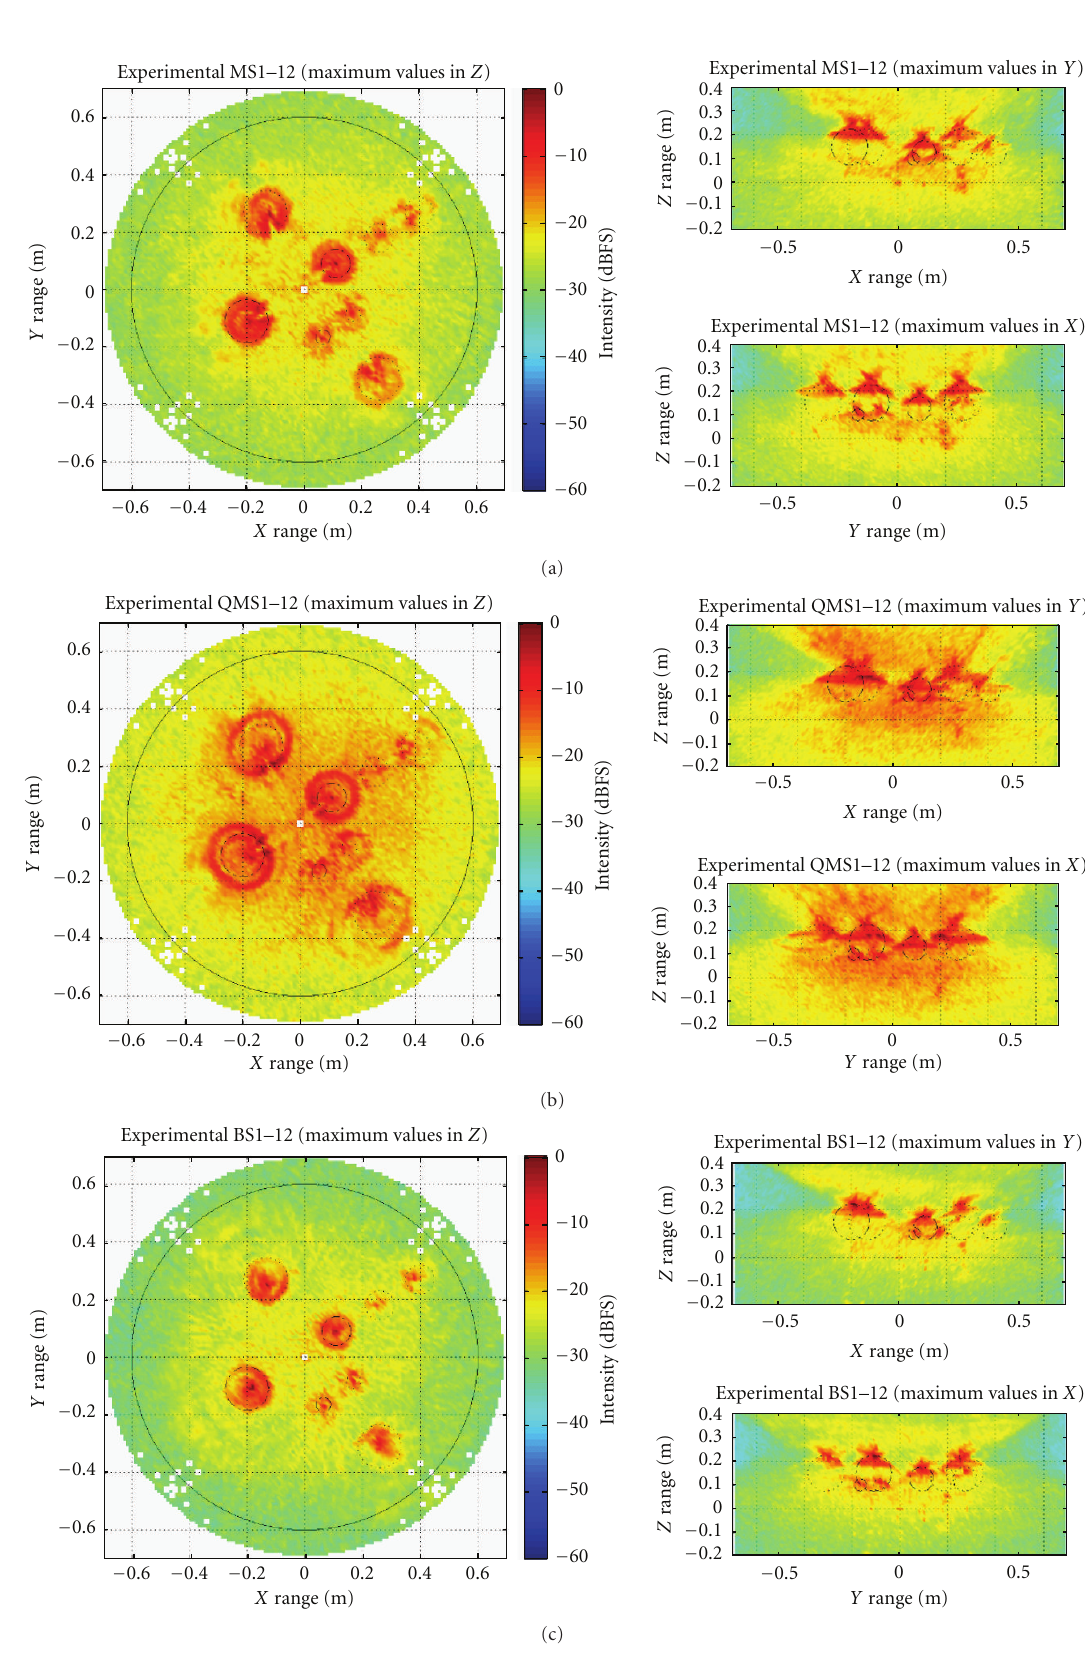
Figure 19: Experimental tomographic reconstruction of the targets seen in Figure 16. (a) (Q)MS antennas, (Q)MS algorithm. (b) BS antennas, (Q)MS algorithm. (c): BS antennas, BS